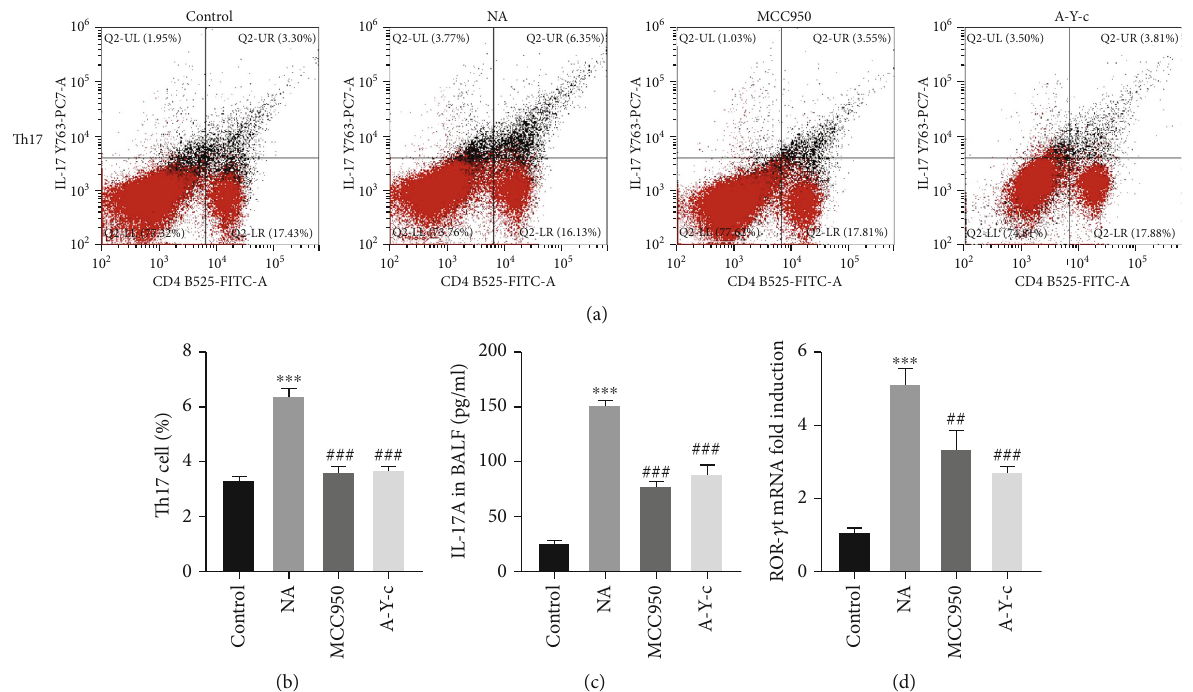
Figure 4: Inhibition of the NLRP3/caspase-1/IL-1 β pathway suppressed ovalbumin-induced Th17 cell response. (a, b) Splenocytes were derived from mice and stimulated with PMA and ionomycin, and after fi xed and permeabilized, cells were incubated with extracellular and intracellular antibodies. Stained cells were run on the CytoFLEX Flow Analyzer and analyzed with the CytExpert software. (c) The concentration of IL-17A in BALF was quanti fi ed by ELISA. (d) mRNA expression of ROR γ t in lung homogenates was detected by real- time PCR. Data are expressed as mean ± SEM . n = 6 . Compared to the control group, ∗ p < 0 : 05 , ∗∗ p < 0 : 01 , and ∗∗∗ p < 0 : 001 ; compared to the neutrophilic asthma group, # p < 0 : 05 , ## p < 0 : 01 , and ### p < 0 : 001 . NLRP3: nucleotide-binding oligomerization domain-like receptor family pyrin domain containing 3; PMA: phorbol 12-myristate 13-acetate; BALF: bronchoalveolar lavage fl uid; ELISA: enzyme- linked immunosorbent assay; ROR γ t: retinoid-related orphan receptor- γ t; PCR: polymerase chain